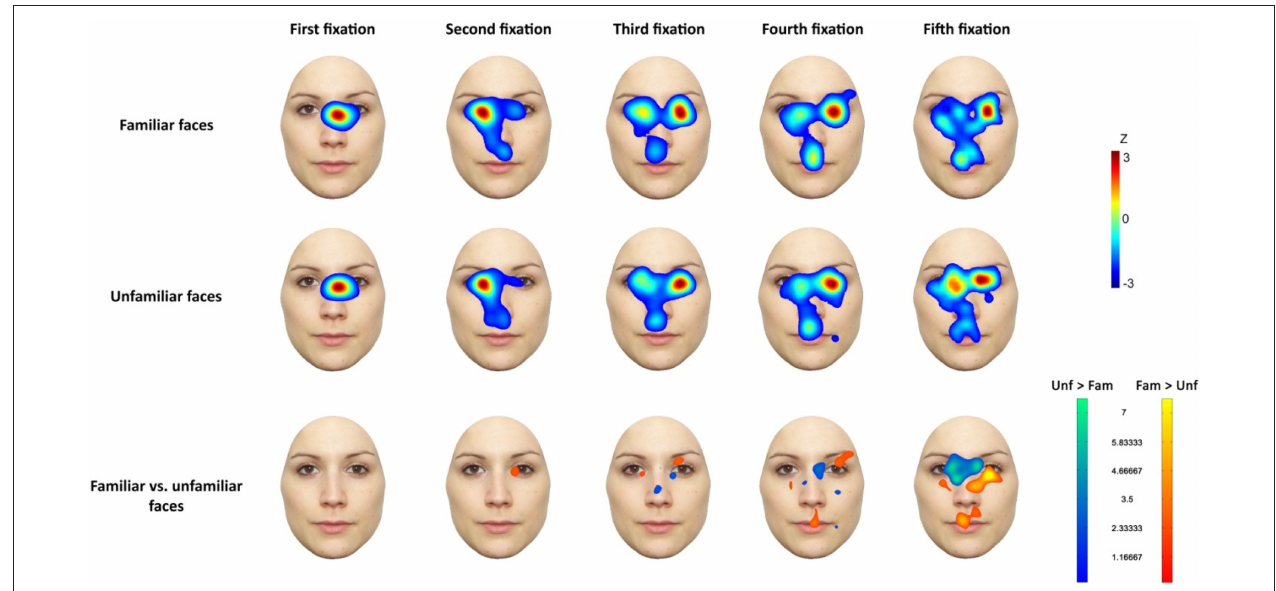
scales represent the amount of fixations per location for each of the experimental conditions, or effect sizes of the differences in fixation locations for un-/familiar face